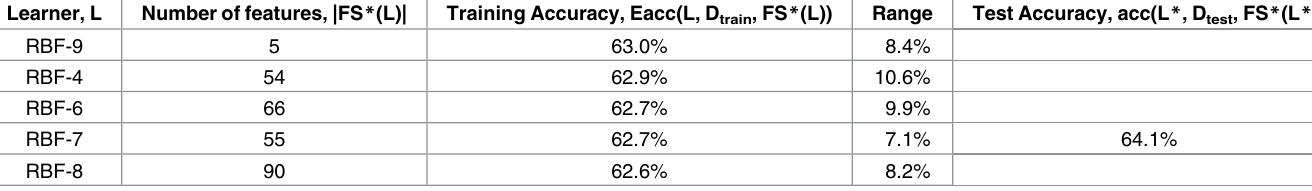
Table 14. ABIDE, personal characteristic data with structural images.